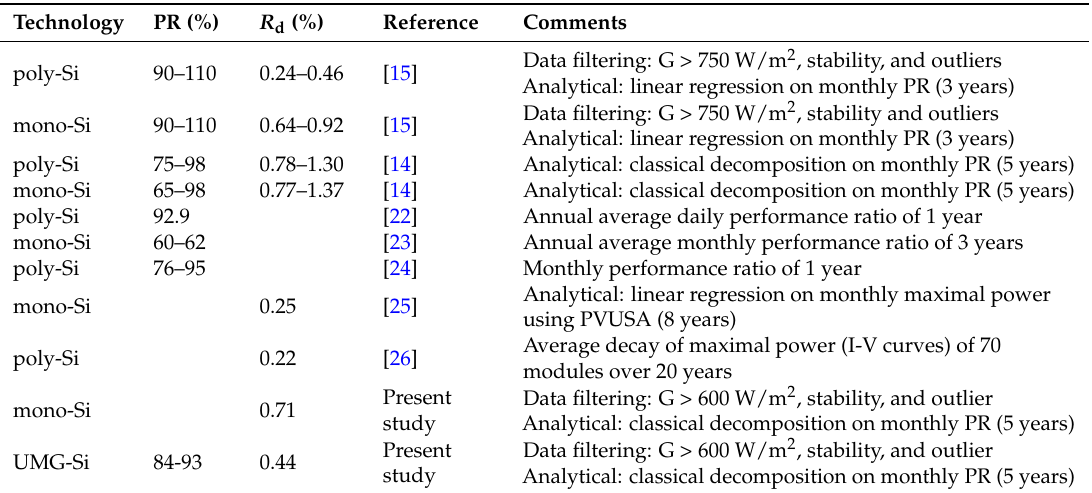
Table 2. Performance comparison with conventional crystalline silicon